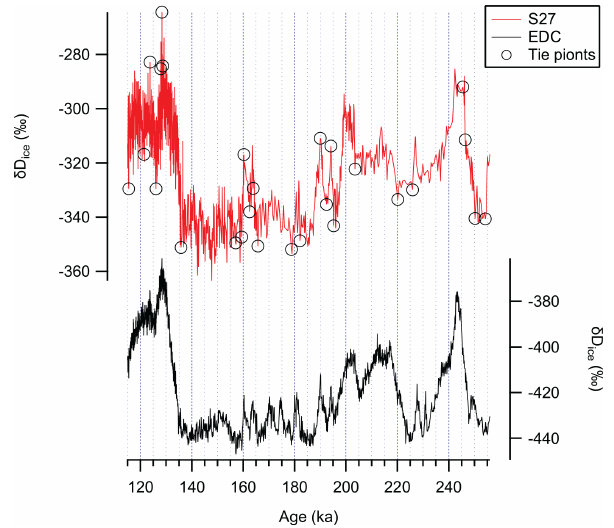
Figure 2. Stable water isotope records in S27 (red; Spaulding et al., 2013) and EDC (black; Jouzel et al., 2007) between 115 and 255ka. Tie points in S27 δ D ice used by Spaulding et al. (2013) are marked as